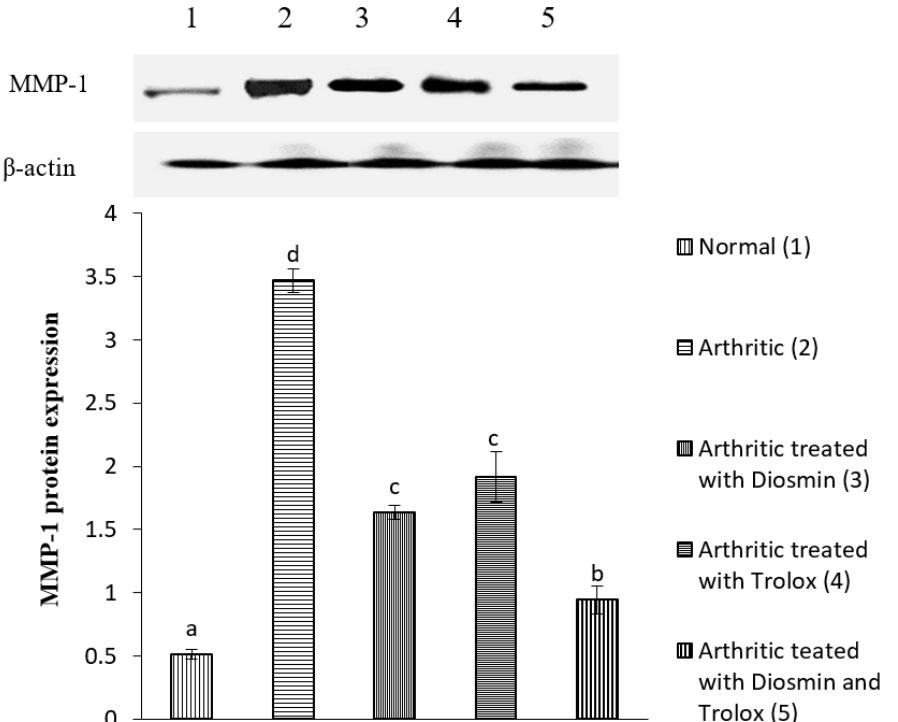
Figure 8. Effect of diosmin, trolox and their combination on MMP-1 protein expression level in CFA-induced arthritic rats. Means that have the same symbol (s) are not significantly different ( n = 3).